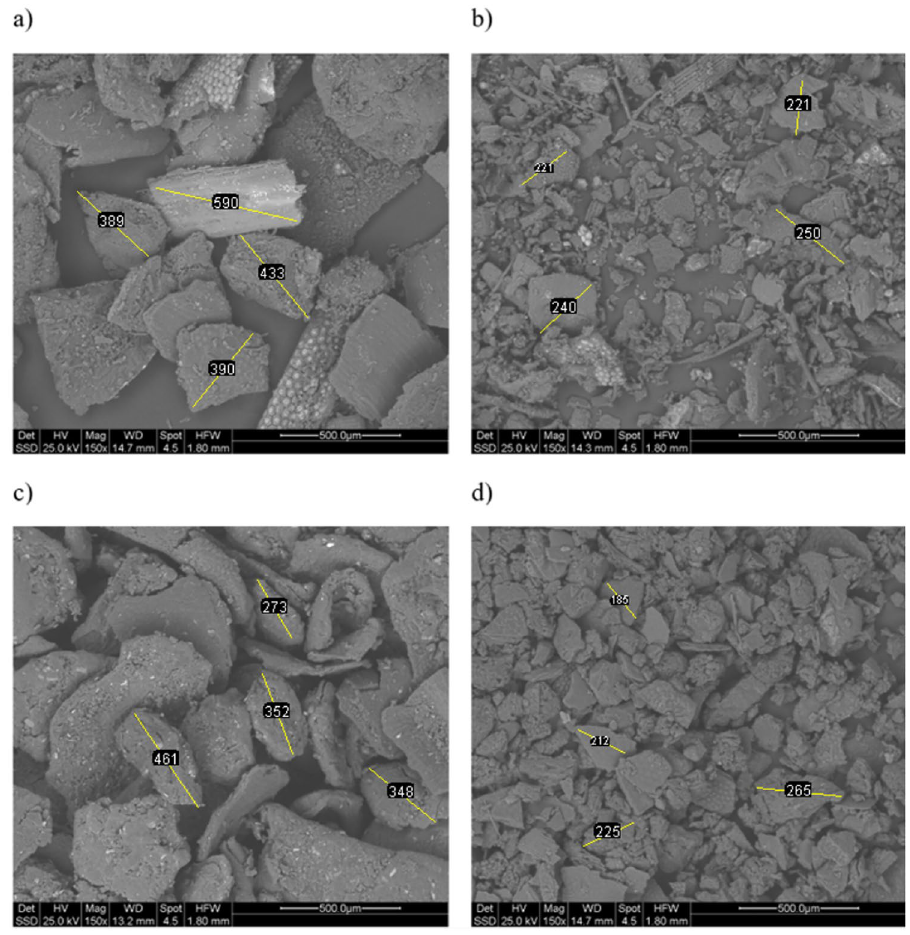
Figure 4. ESEM micrograph of the backscattered electrons at 150X, all the measure are expressed in μm: ( a ) S1 > 250, ( b ) S1 < 250, ( c ) S2 > 250, ( d ) S2 <